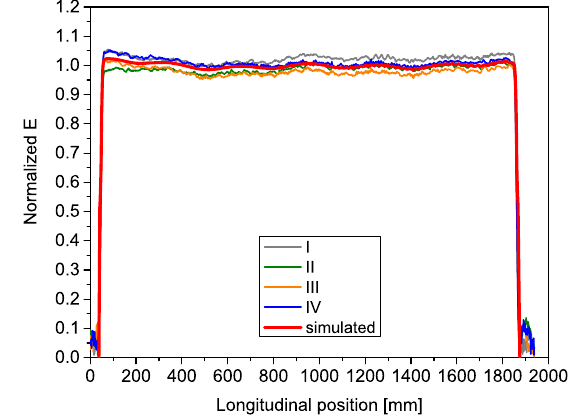
FIG. 19. Tuned electric field along the RFQ cold model for four quadrants. The simulated field is also included for